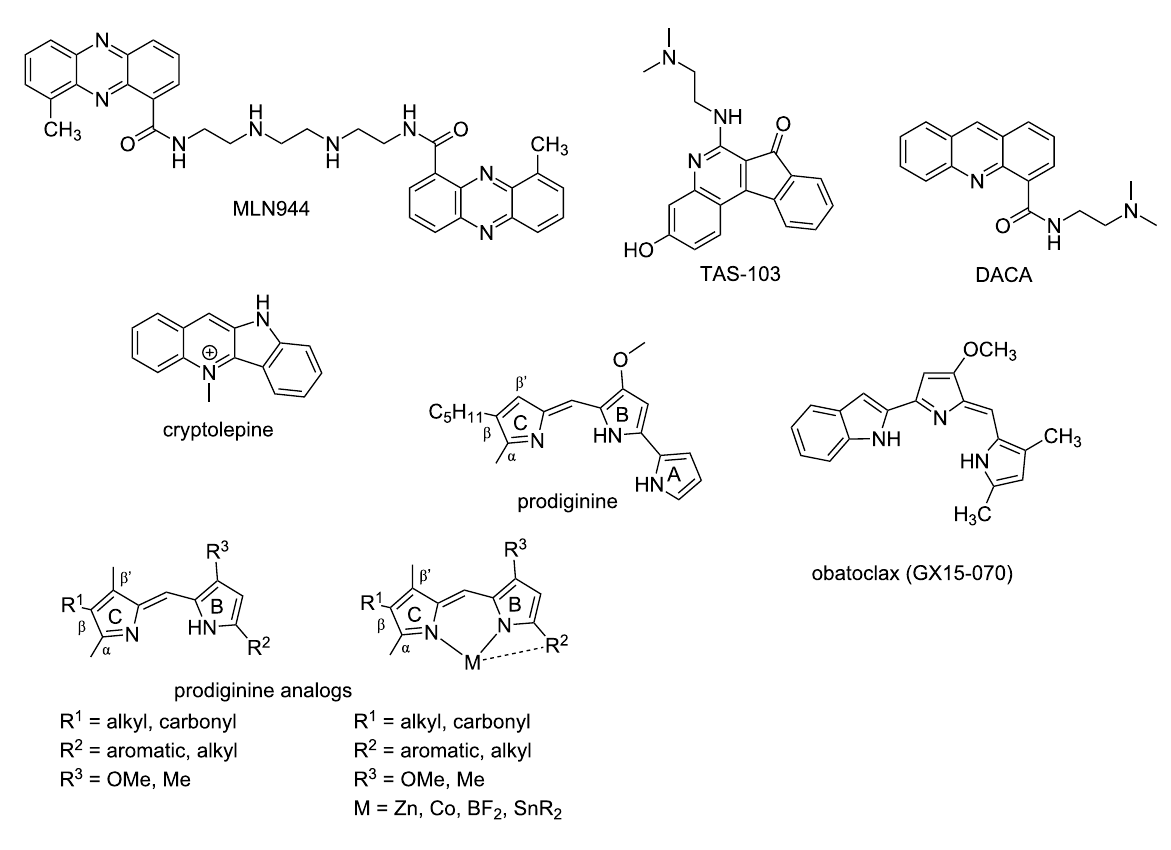
Figure 16: Representative examples of naturally occurring and synthetic derivatives of DNA intercalating